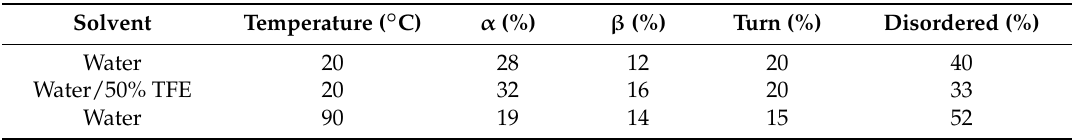
Table 1. Estimated secondary structure elements composition of recombinant Id2 (cid:48) (30 µ M), as obtained by deconvolution of the CD spectra 1 .